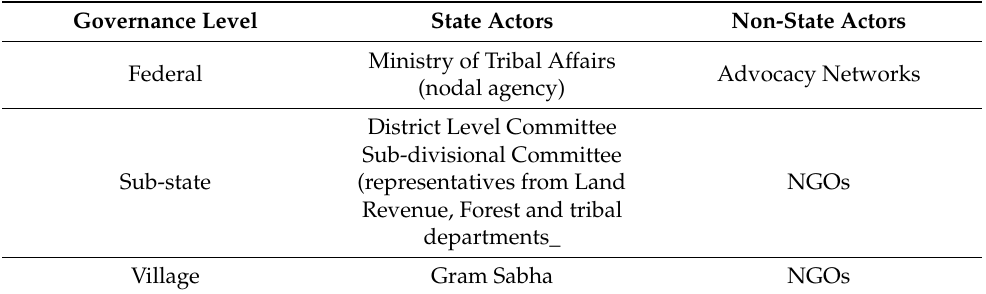
Table 3. Decentralized land administration structure under the Recognition of Forest Rights) Act 2006